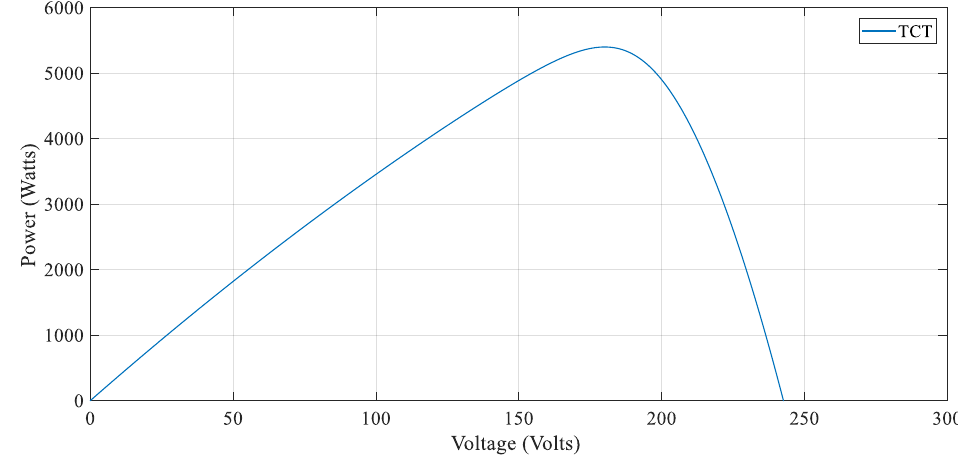
Figure 6. P-V curve for 6 × 6 PV array under normal conditions ( STC ).